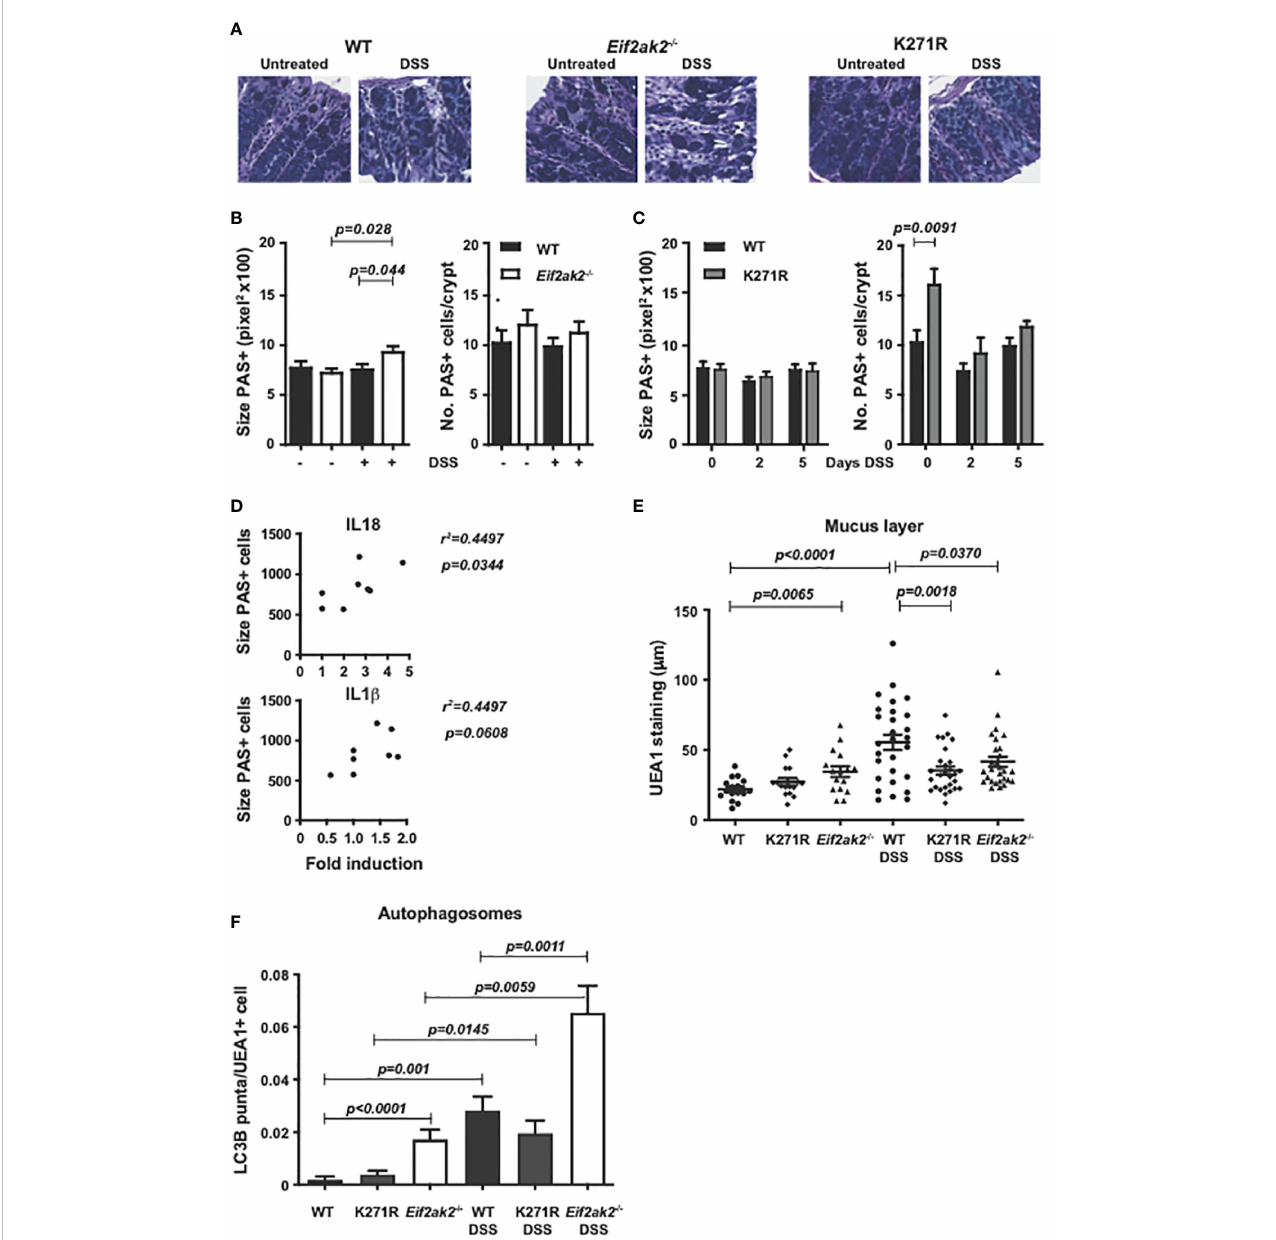
FIGURE 7 PKR alters gut physiology. (A) Micrographs of histologic specimens of the colon from WT, PKR-ablated ( Eif2ak2 -/- ) and kinase-dead (K271R) mice stained with PAS. Representative images are shown from two independent experiments. (B, C) Quantitation of the size and number of goblet cells visualized by PAS staining of colon from (B) WT and PKR-ablated ( Eif2ak2 -/- ) mice (H 2 O n=4 and DSS n=7) or (C) WT and kinase-dead (K271R) mice, either untreated or treated with DSS for 5 days or as indicated (H 2 O n=4 and DSS n=7). Data were analyzed by two-way ANOVA with S ̌ idàk post-test. (D) Correlation analysis between the fold induction of IL18 or IL1 b and the average goblet cell size from WT and PKR-ablated ( Eif2ak2 -/- ) mice (n=6). (E) Measures of the relative thickness of the mucus lining as visualized with UEA1 probing of colon tissues from the indicated mice, either untreated or treated with DSS in their drinking water for 5 days (H 2 O n=4 and DSS n=7). Each data point represents quanti fi cation of one fi eld, with four to fi ve fi elds assessed per confocal image per mouse. The data were analyzed by two-way ANOVA with S ̌ idàk post-test. (F) Measures of autophagy were made by quantitation of LC3B puncta, identi fi ed as circular objects with a diameter of 10-70 pixels, in UEA1-positive cells from the indicated mice, either untreated or treated with DSS in their drinking water for 5 days (H 2 O n=4 and DSS n=7). 2000-4000 UEA1 positive cells were scored per microscopic fi eld using CellPro fi ler software. Data are expressed as mean ± S.E.M. and analyzed by two-way ANOVA with S ̌ idàk